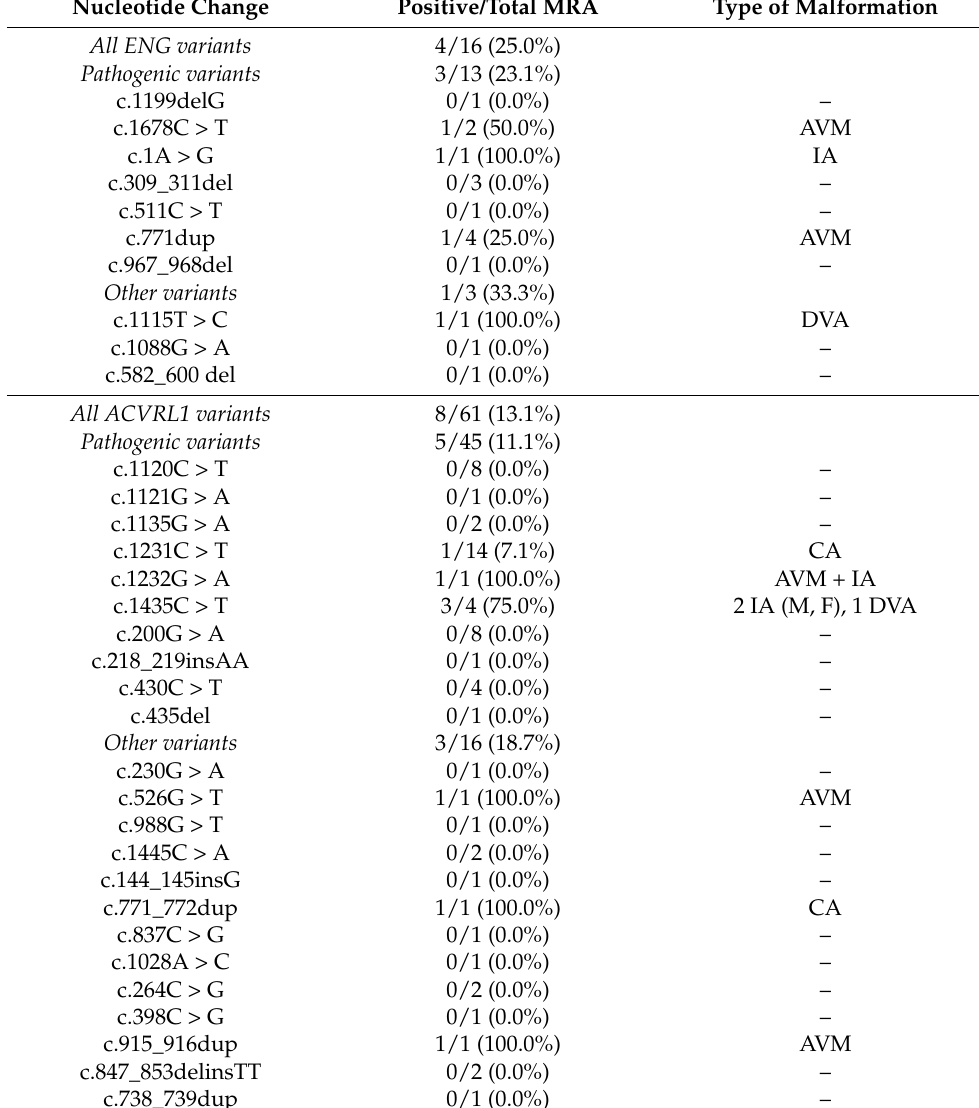
Table 3. Distribution of cerebrovascular malformations according to ENG and ACVRL1